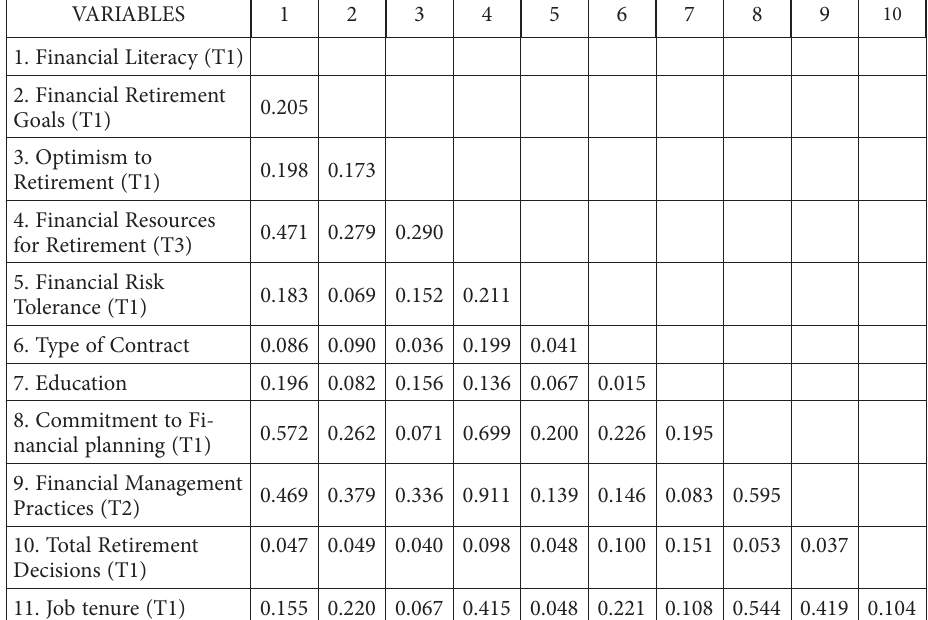
Table 4. Measurement model: Discriminant Validity according to HTMT criteria